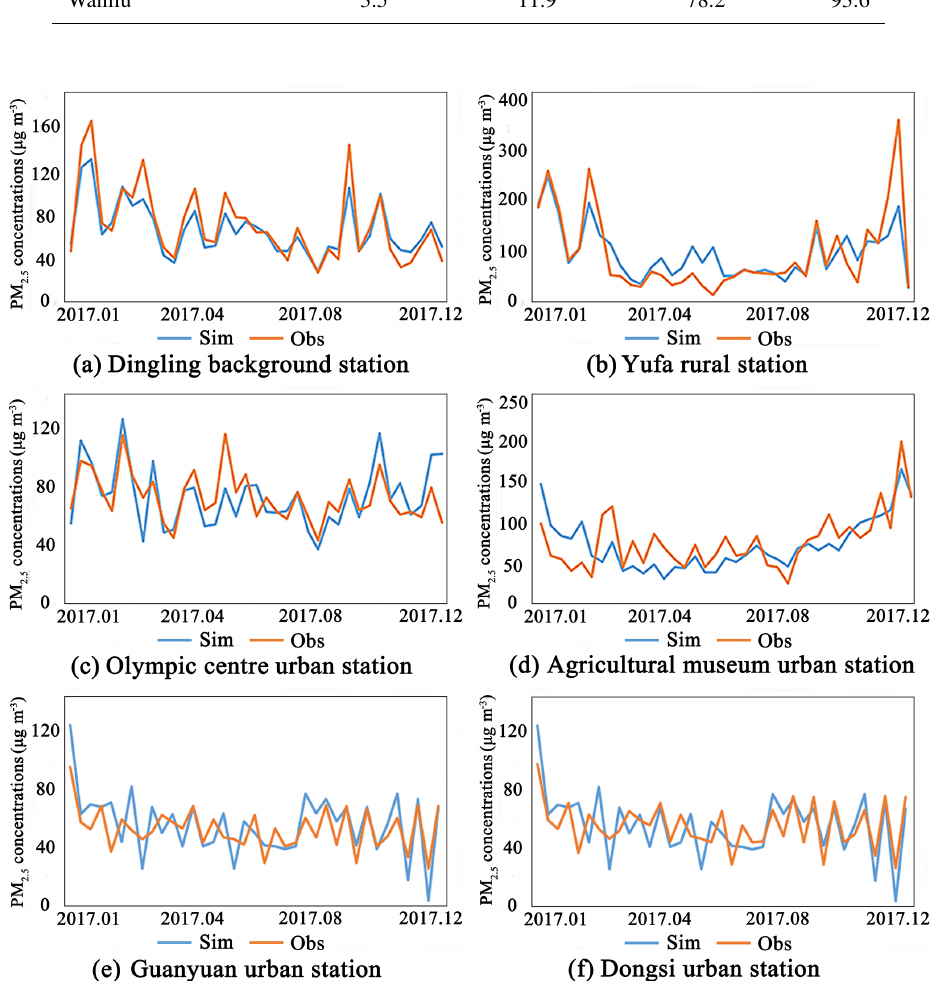
Figure 3. The comparison between observed and WRF-CMAQ simulated PM 2 . 5 concentrations in 2017 at six stations across